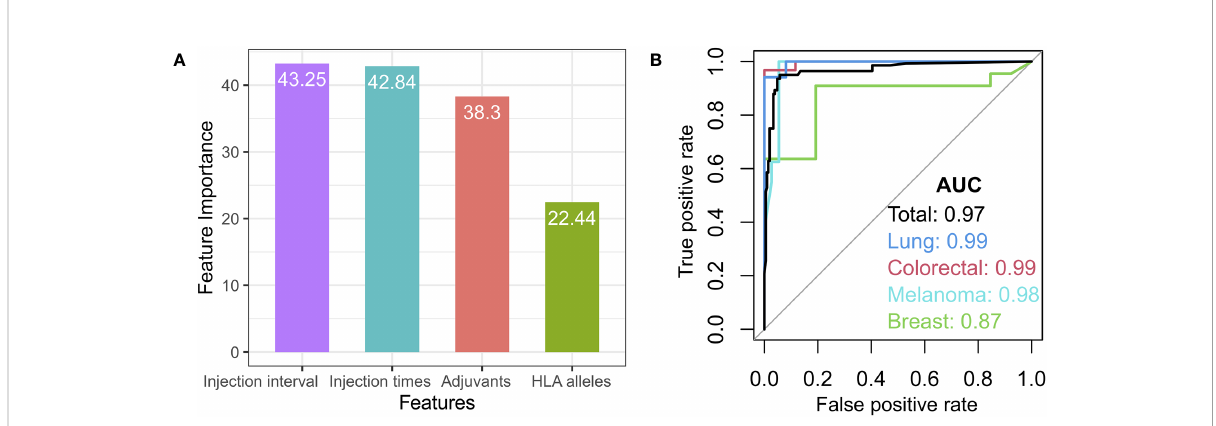
FIGURE 7 Features selection and model. (A) The variable importance for the selected features, such as injection interval, injection times, adjuvant types, and HLA alleles. (B) Receiver Operating Characteristic (ROC) curve for the total test set (black) and independent breast cancer (green), melanoma (light blue), lung cancer (blue), and colorectal cancer datasets